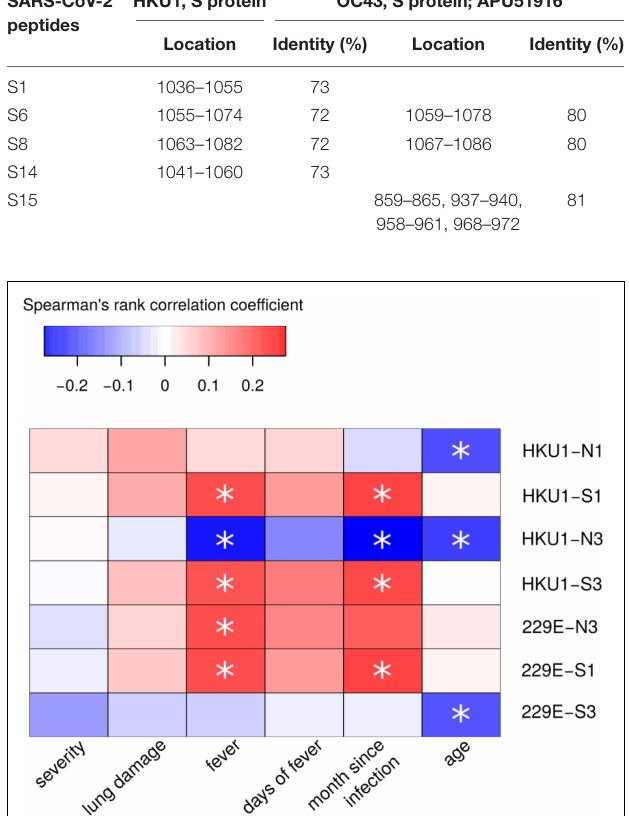
TABLE 2 | Amino acid location displaying ≥ 70% identity between SARS-CoV-2 and eCoVs in S protein. SARS-CoV-2 HKU1, S protein peptides